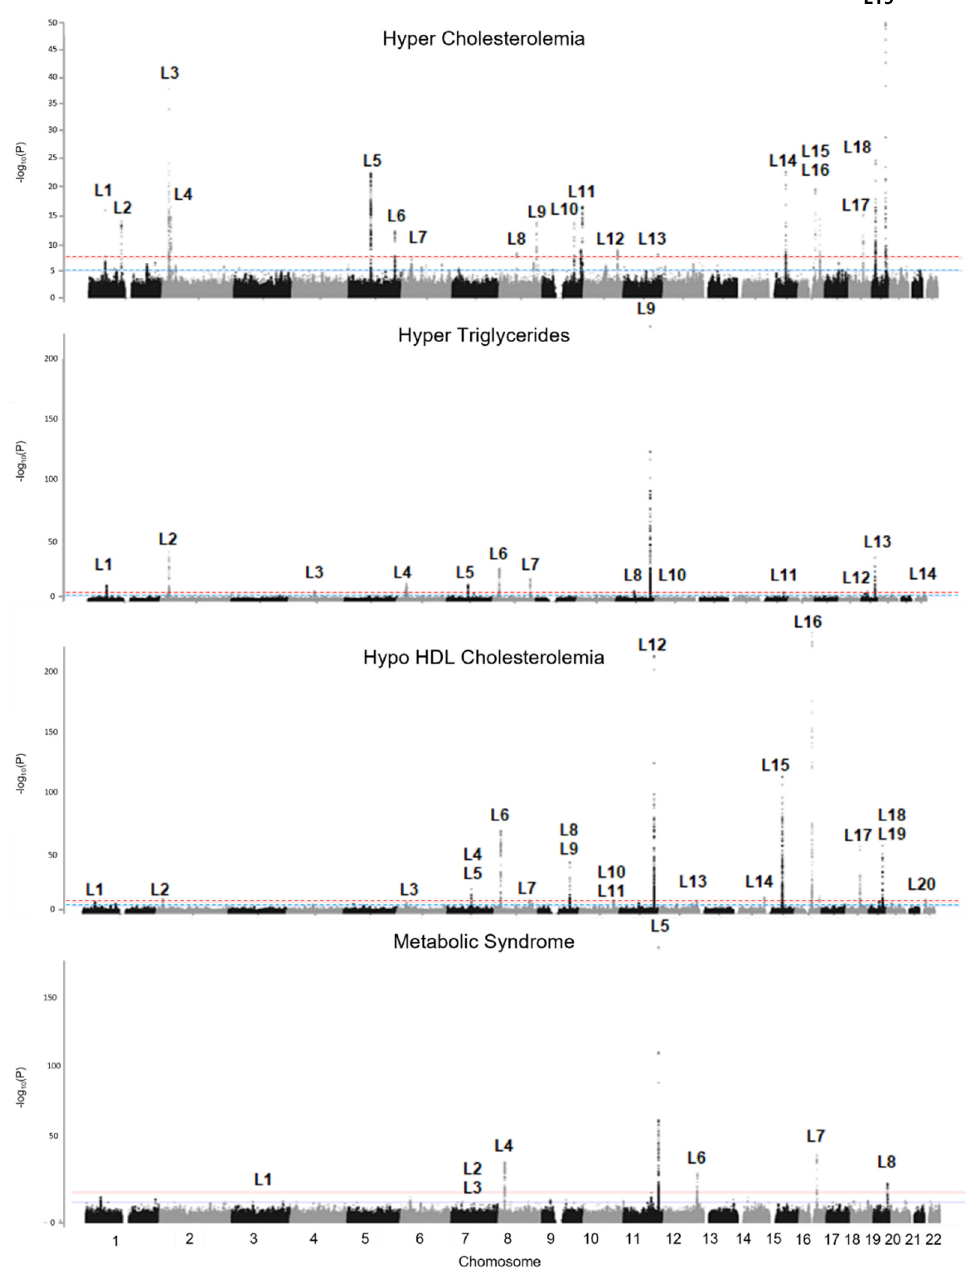
Figure 2. Manhattan plots of each GWAS p -value. The X-axis is the number of chromosomes, and the Y-axis is the minus Log 10 (P). Each locus was numbered using the ‘L’ character, which indicated the significant locus. The same ‘L’ characters and numbering between Manhattan and Miami plots indicated the same locus, which implied that the locus was similarly associated with the phenotype in both the total group and subgroup. We extracted the most significant SNP (top signal) for each locus.